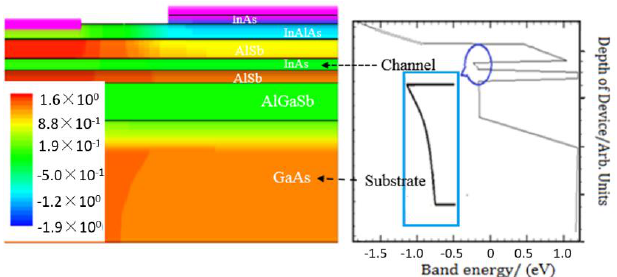
Figure 2. Longitudinal distribution of conductive band in heterojunction zone from simulation.